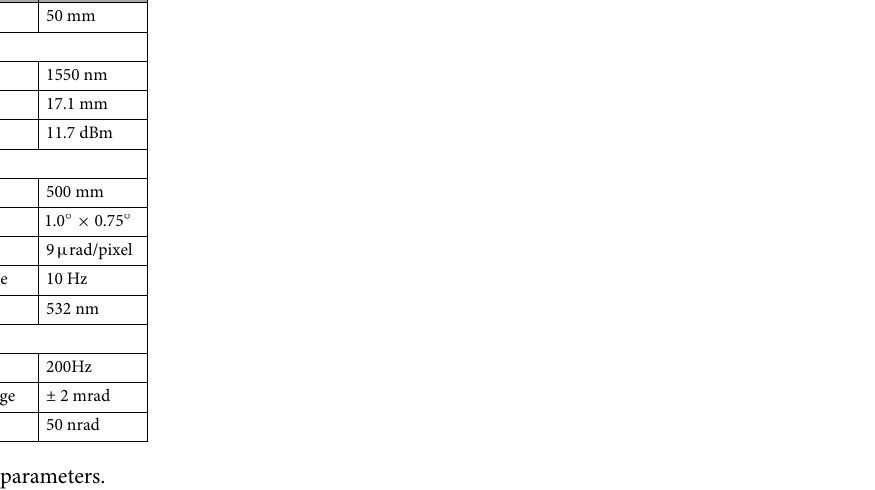
Table 1. Mount parameters.